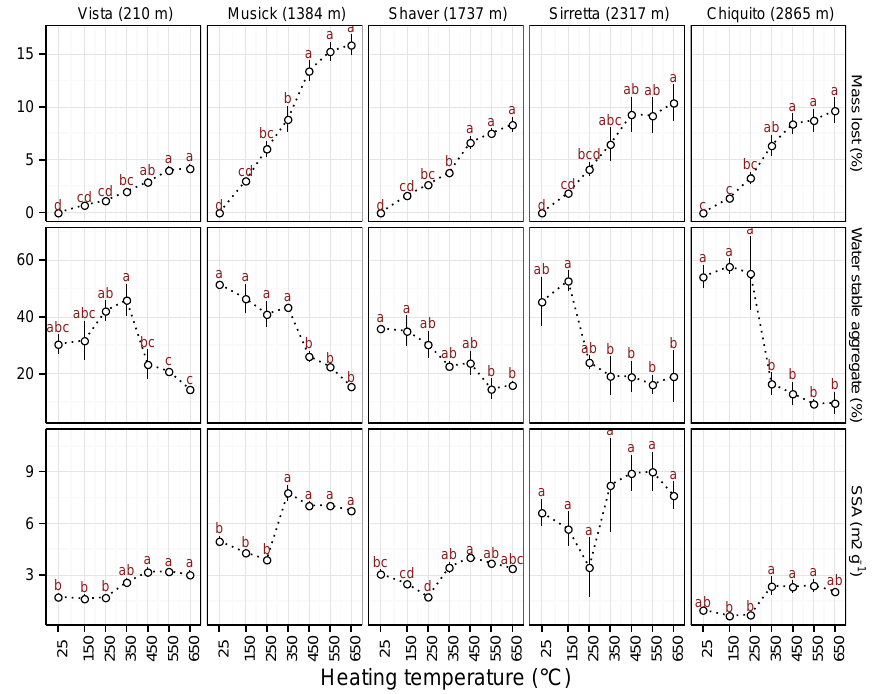
Figure 4. Percent mass lost, water-stable aggregate percent and specific surface area changes with increase in heating temperatures. Error bars represent standard error where n = 3. Different letters represent significantly different means ( p < 0.05) at temperature after Tukey’s HSD testing.